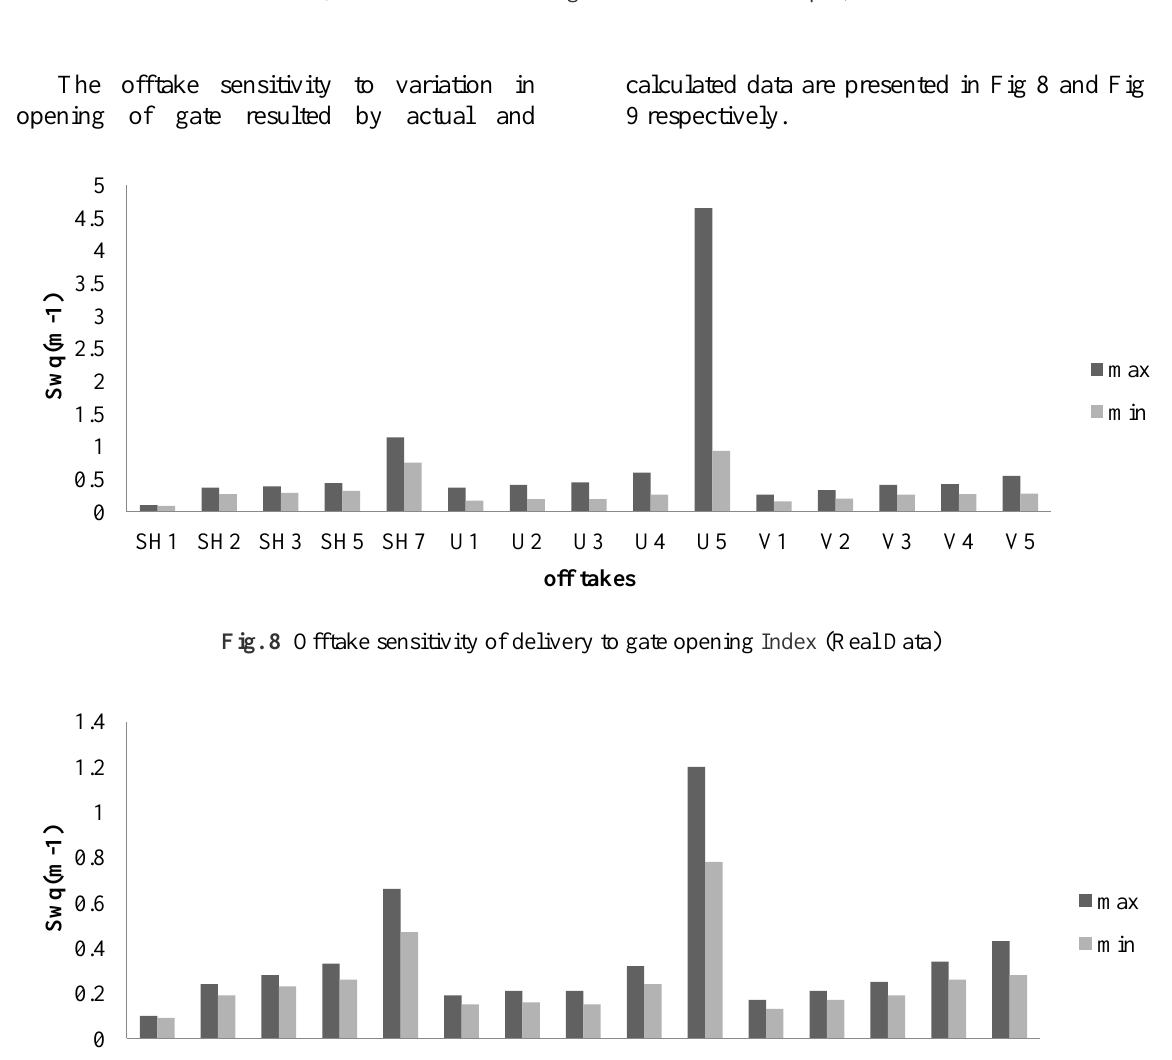
Fig. 7 Structure performance SH7 baffle module in Sobek model (The baffle is not working due to the flow low depth)